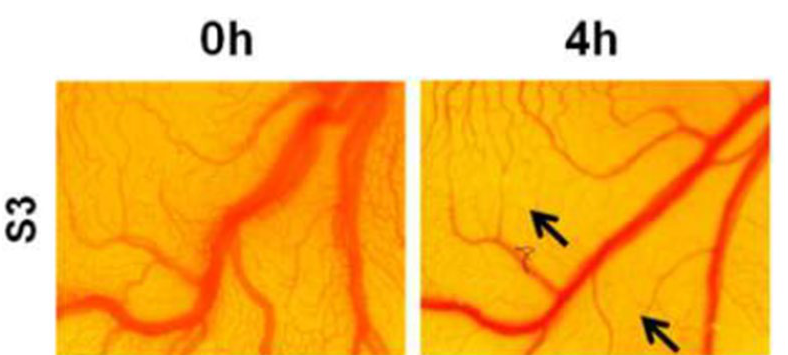
Figure 8. Antiangiogenic properties of MSNMP-SnPh 3 (S3) in chick embryo assay (CAM) at 4 h post-treatment. Arrows show the main areas where reduction in the vascularization is visible [89]. Reproduced with permission. Copyright © Elsevier.